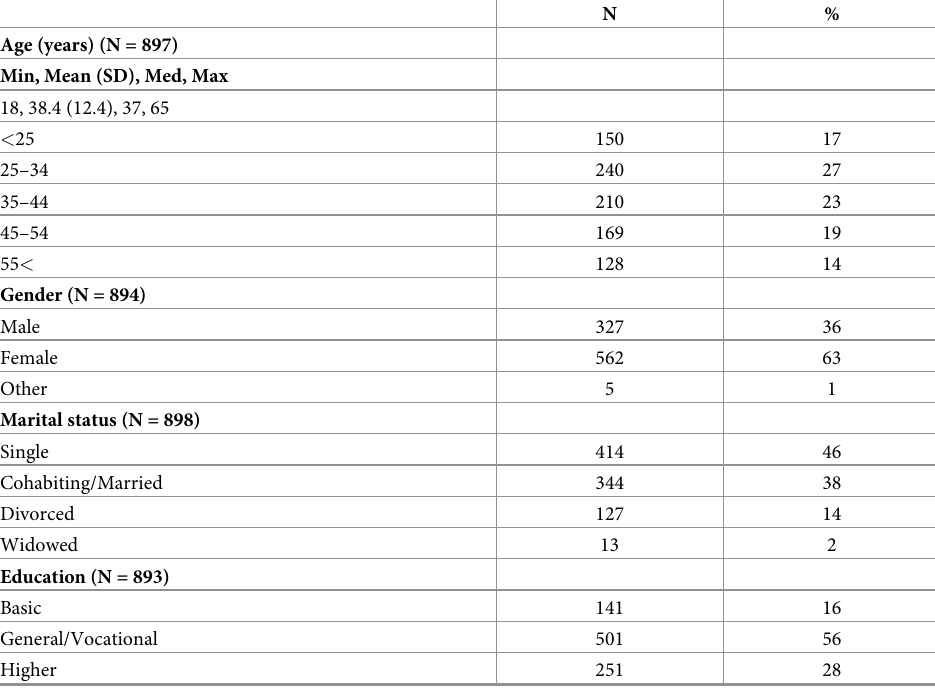
Table 1. Sociodemographic and clinical characteristics of all the respondents (N = 898).